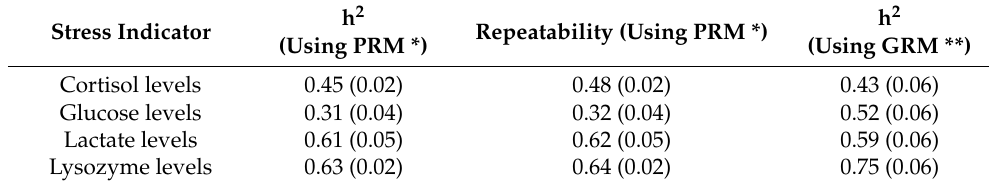
Table 2. Heritability (h 2 ) and repeatability per trait per model for biochemical and homological factors. Standard errors are illustrated in the